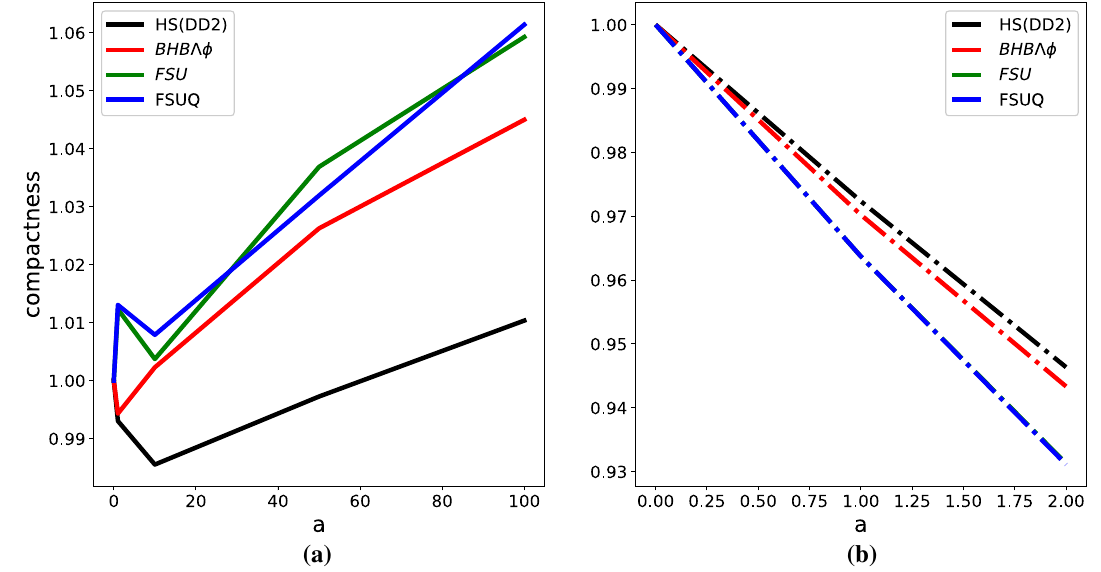
Fig. 5 a Compactness normalized with respect to the GR compactness for non-perturbative method. b Compactness normalized with respect to the GR compactness for perturbative method